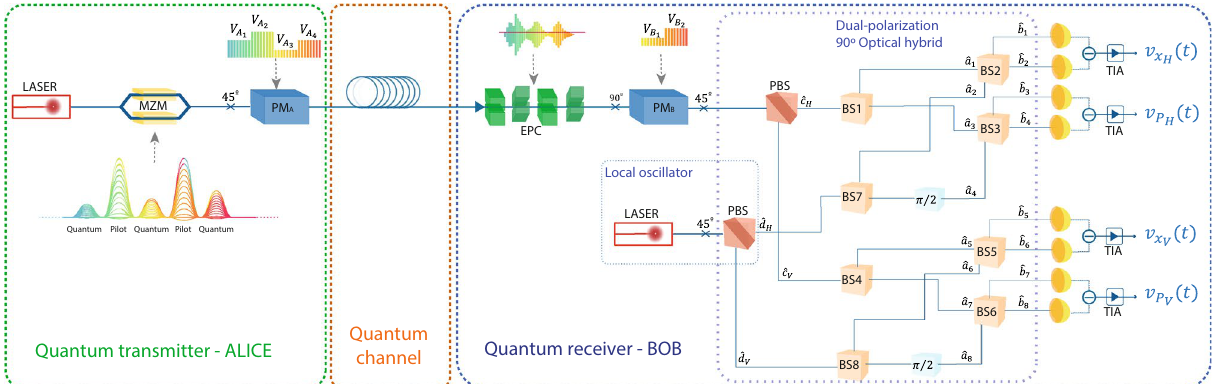
Figure 1. Schematic representation of the discrete variable quantum key distribution (DV-QKD) system based on polarization diversity coherent detection. [MZM] denotes the Mach–Zehender amplitude modulator, [ PM A ] and [ PM B ] the phase-modulators of Alice and Bob, respectively, [EPC] the electronic polarization controller, [PBS] the polarization beam-splitters, [BS] the beam-splitters, and [TIA] the trans-impedance